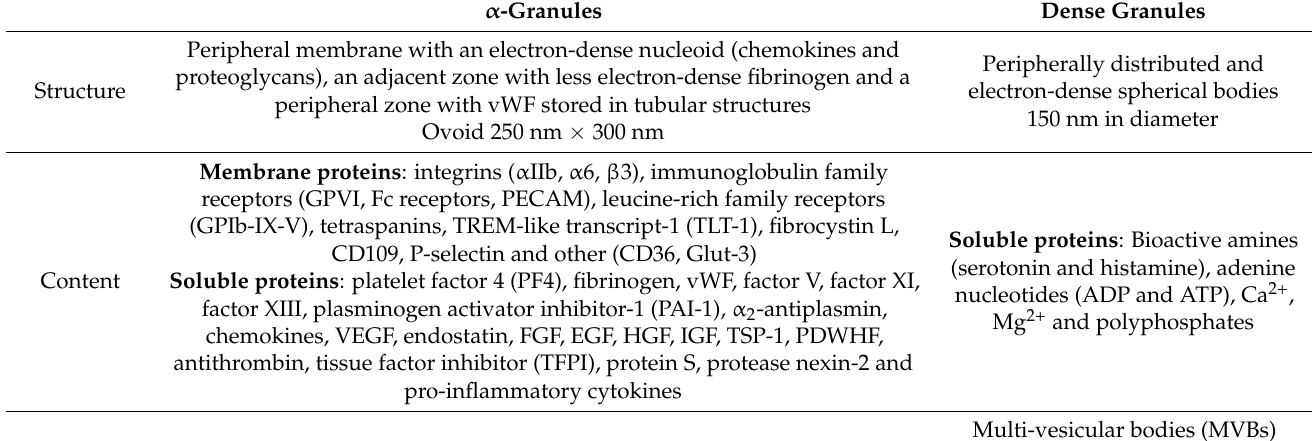
Table 1. Properties of α -granules and dense granules [42,50–53]. α